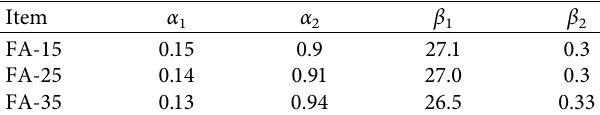
Table 5: Model parameters for the estimation of the tensile strength and the elastic modulus.